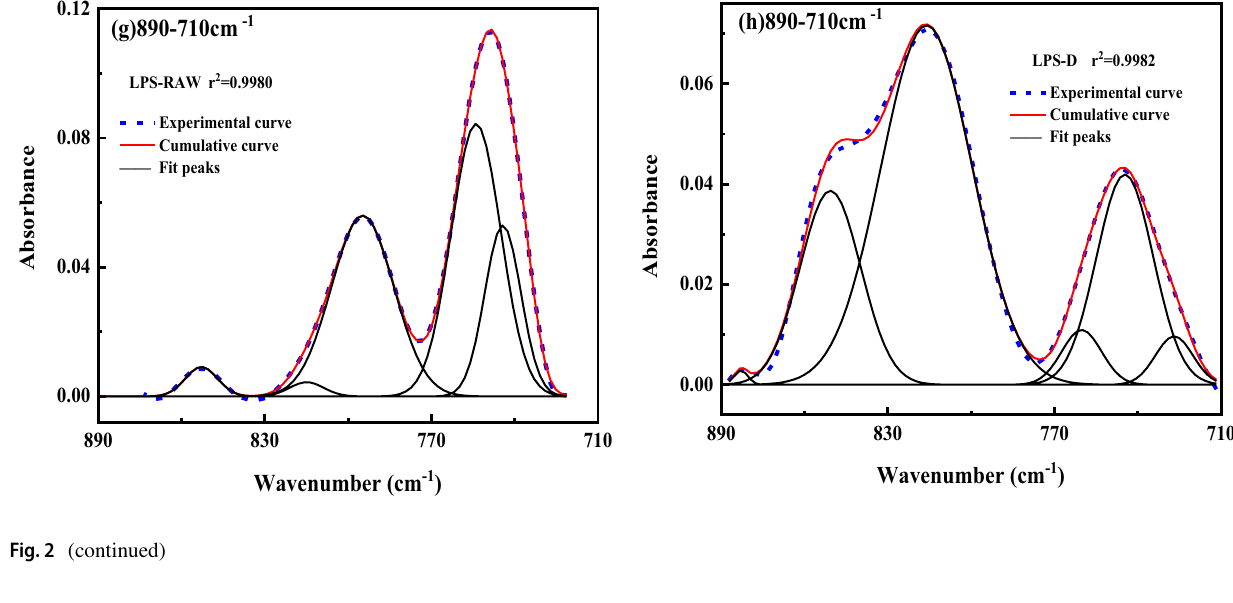
Table 2 Assignments for peaks in FTIR absorption wavenumber and corresponding